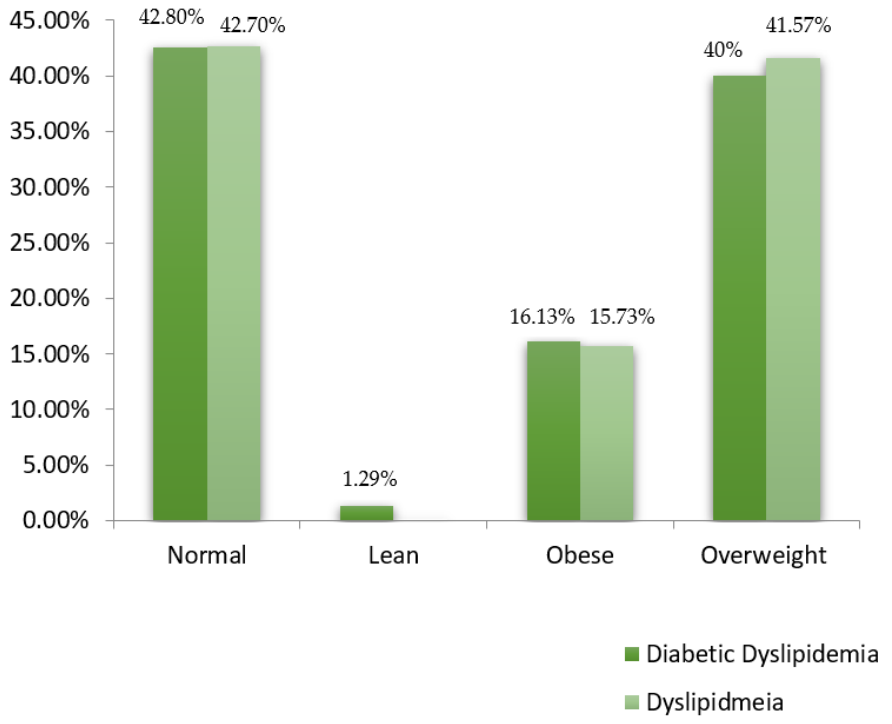
Figure 4. A bar chart representing the proportion of study subjects with reference to their BMI.